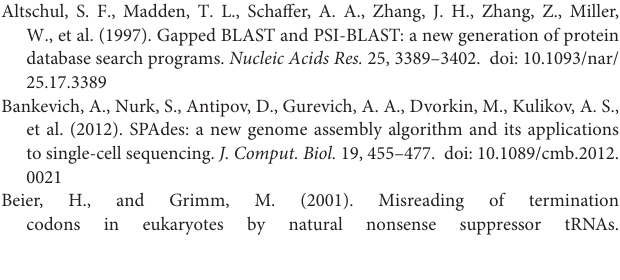
Supplementary Table S4 | Comparison of genes content among members of Ulvophyceae.